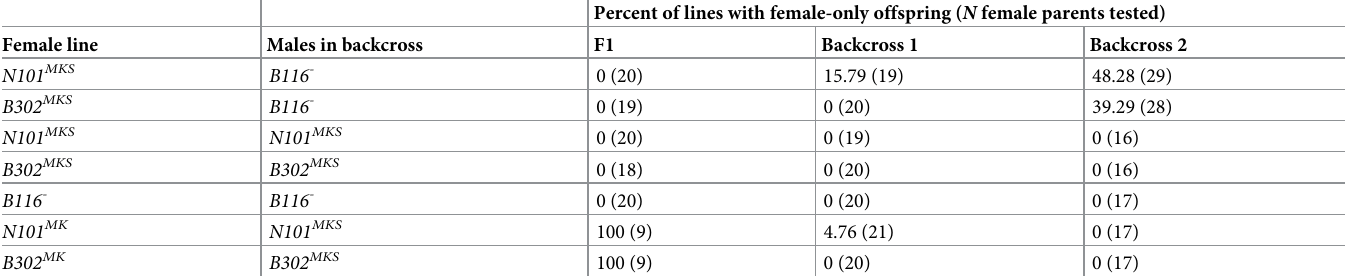
Percent of lines with female-only offspring ( N female parents tested)